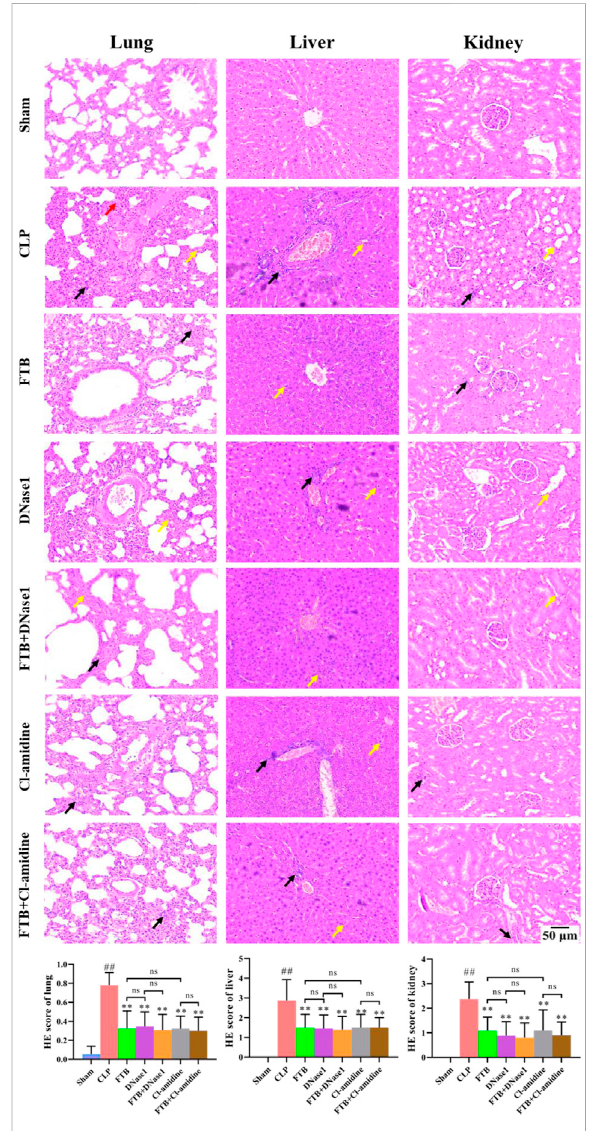
FIGURE 7 Effects of FTB on CLP-induced pathological changes and tissue injury scores of the lung, liver and kidney in rats with sepsis after inhibiting the NETs formation and the activity of PAD4. Treatment with FTB, DNase1 (NETs inhibitor) and Cl-amidine (PAD4 inhibitor) improved the CLP-induced pathological changes in the lung (red arrows indicate the pulmonary interstitial congestion, yellow arrows indicate the thickened alveolar walls and black arrows indicate the in fi ltration of in fl ammatory cells), liver (yellow arrows indicate the necrotic hepatocytes and black arrows indicate the in fi ltration of in fl ammatory cells) and kidney (yellow arrows indicate the enlarged lumen of focal tubules and black arrows indicate the interstitial in fl ammatory cell in fi ltration), and decreased the tissue injury scores. However, no differences wereobservedinthepathologicalchangesandtissueinjuryscores between the FTB and DNase1 groups, FTB and Cl-amidine groups, DNase1 and FTB + DNase1 groups, and Cl-amidine and FTB + Cl- amidine groups (magni fi cation: ×100). Sham group ( n = 15), CLP group ( n = 8), FTB group ( n = 10), DNase1 group ( n = 9), FTB + DNase1 group ( n = 10), Cl-amidine group ( n = 10), FTB + Cl- amidine group ( n =